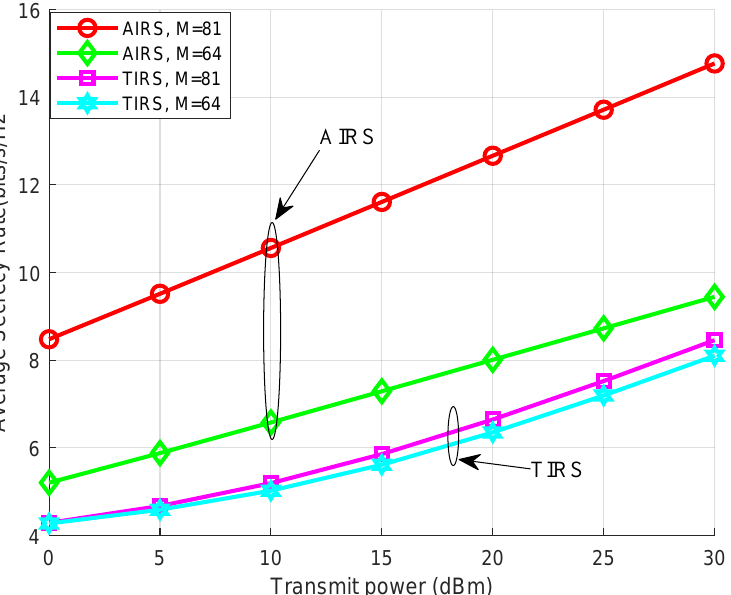
Figure 5. Secrecy rate versus the transmit power at Alice, in which the number of reflecting elements is set to M = [ 64,81 ]